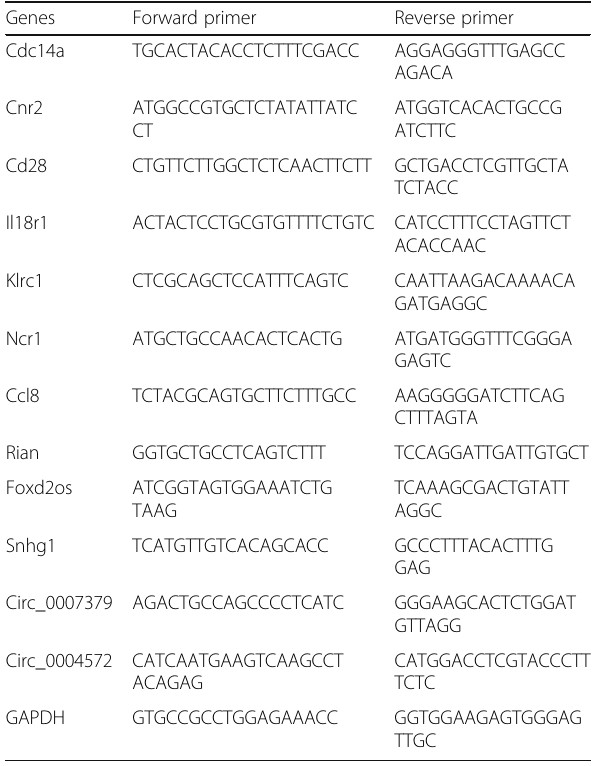
Table 2 Sequences of the primers used for